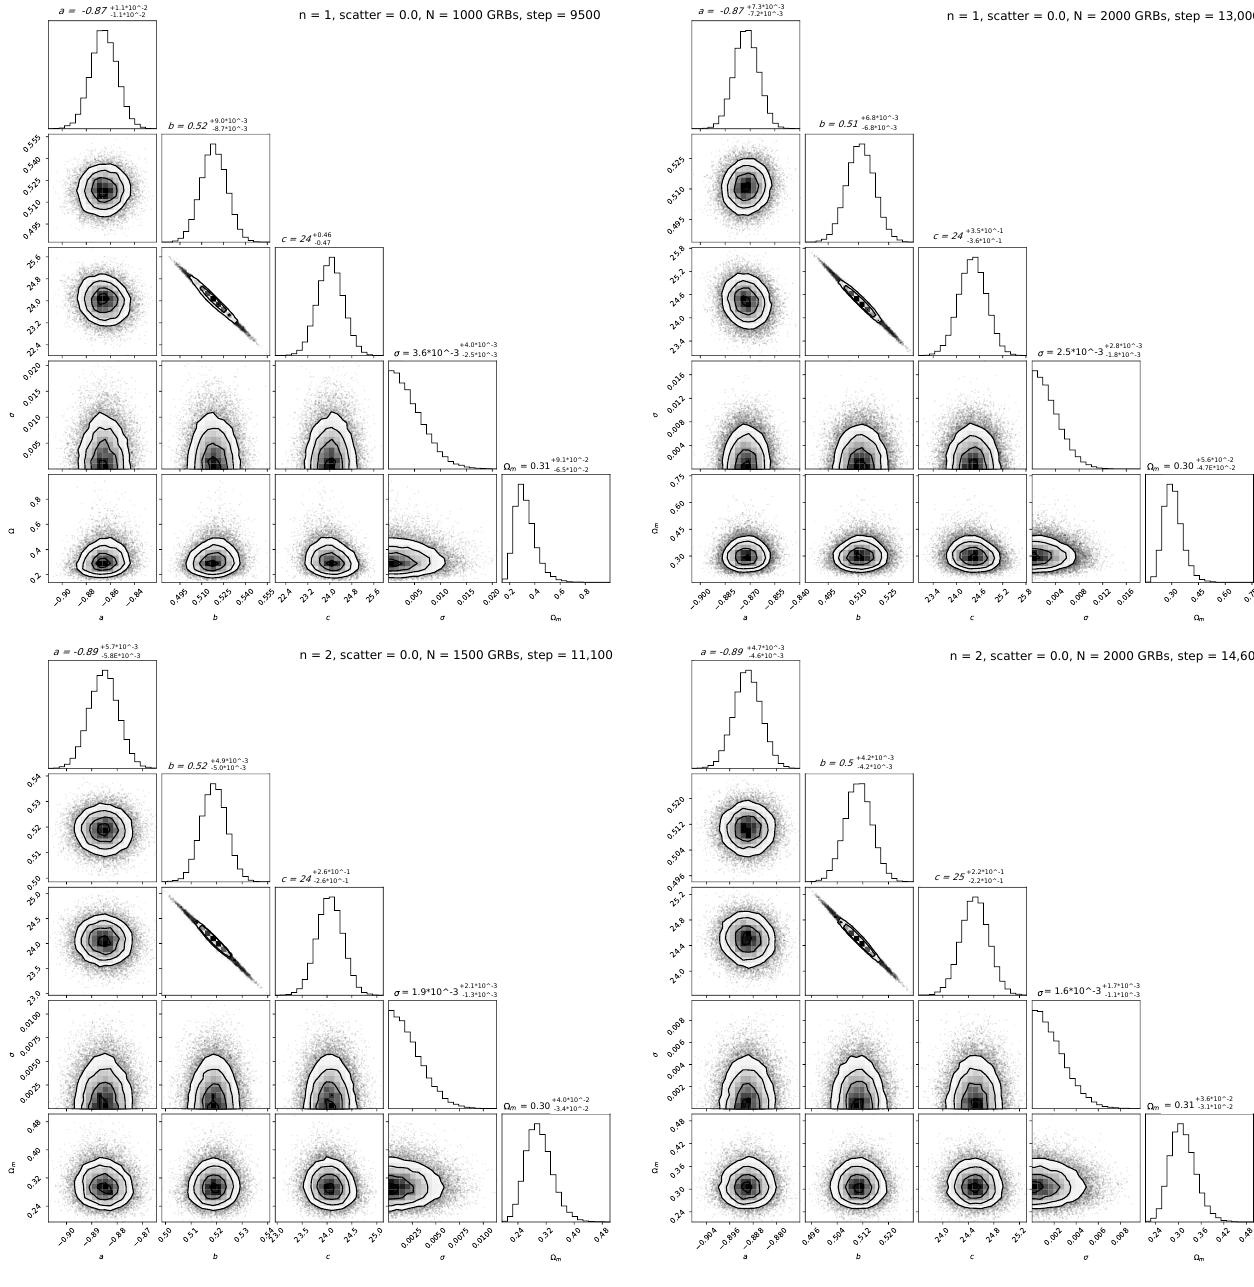
Figure 2. Upper left. An example of 1000 simulated GRBs with the posterior distribution of the fundamental plane parameters a , b , c , and its intrinsic scatter σ together with the total matter density parameter Ω 0 m . In this case, the steps of the simulation are 9500 and the errors on the variables of the fundamental plane have not been divided by any factor ( n = 1). Upper right. The same case of the upper left panel, but considering 2000 GRBs and a number of steps of 13,000. Lower left. The results of 1500 simulated GRBs, dividing by two the errors on the fundamental plane variables (halved errors, n = 2): here the steps are 11,100. Lower right. The same result of the lower-left panel, considering 2000 GRBs and 14,600 steps